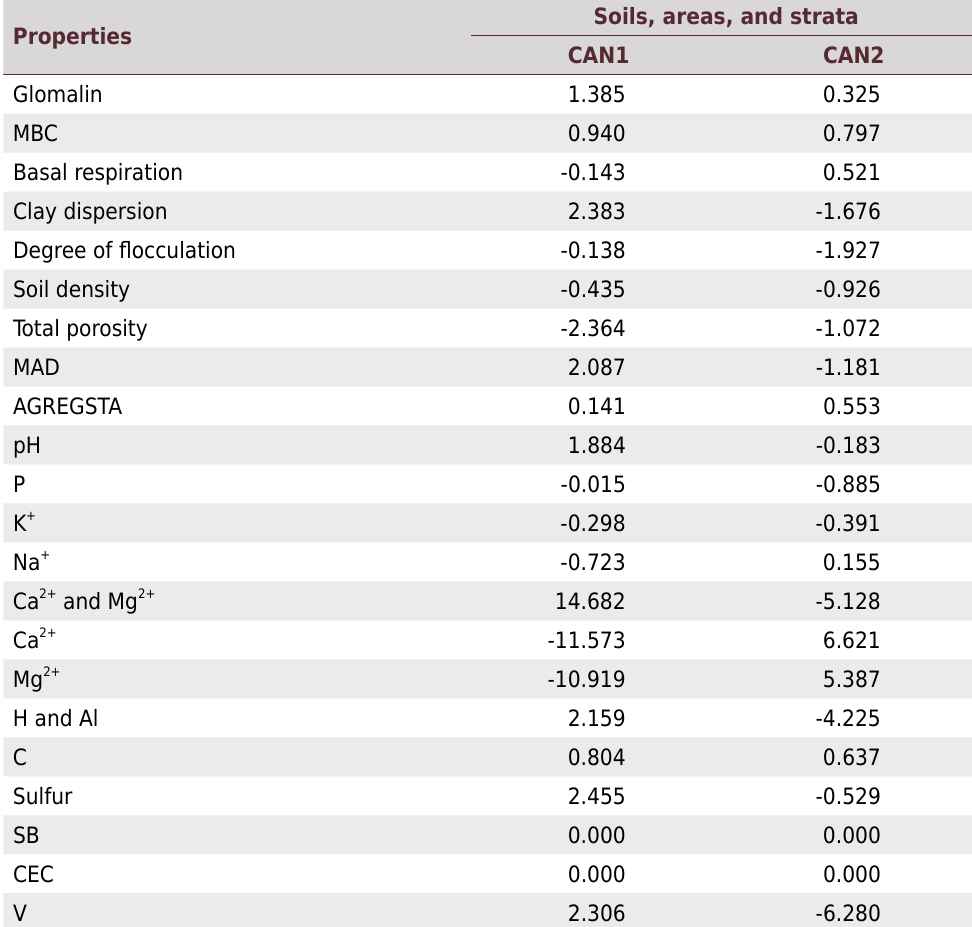
MBC = microbial biomass carbon; MAD = mean aggregate diameter; AGREGSTA = aggregate stability; SB = sum of bases; CEC = cation exchange capacity; V = base saturation. CAN1 and CAN2 = first and